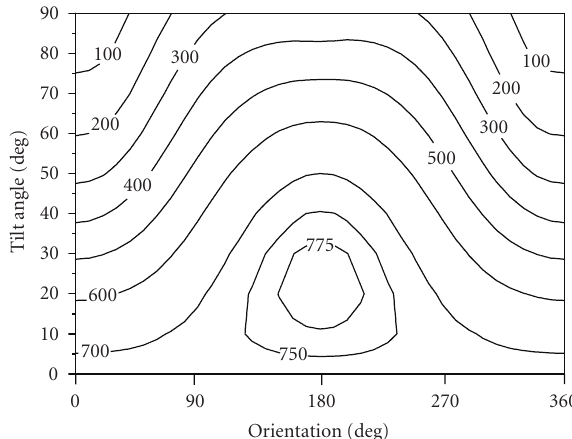
Figure 3: Annual beam solar radiation (kWh/m 2 ) for various tilt angles and